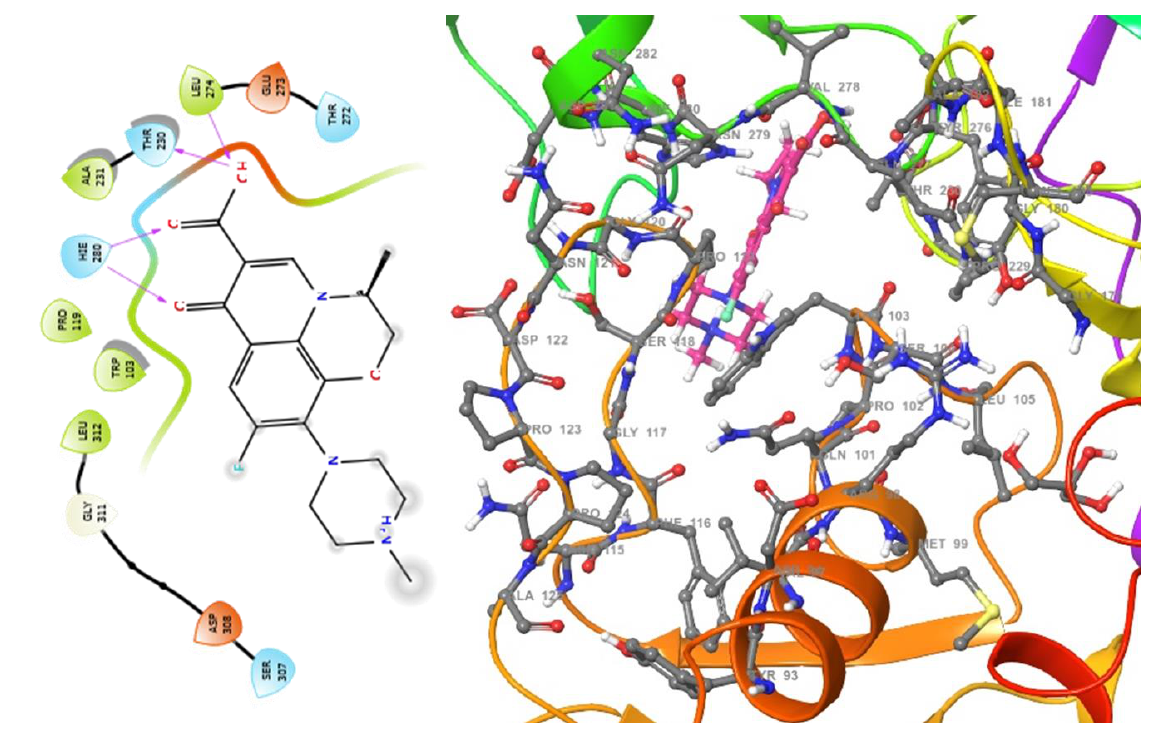
Figure 3. 2D ( left ) and 3D ( right ) views of the molecular interactions at the surface of the active site of the DNA gyrase subunit A N-terminal domain binding with levofloxacin (the green stick model). The negative, positive, and neutral charges of the binding site residues are represented with red, blue, and white colors, respectively.